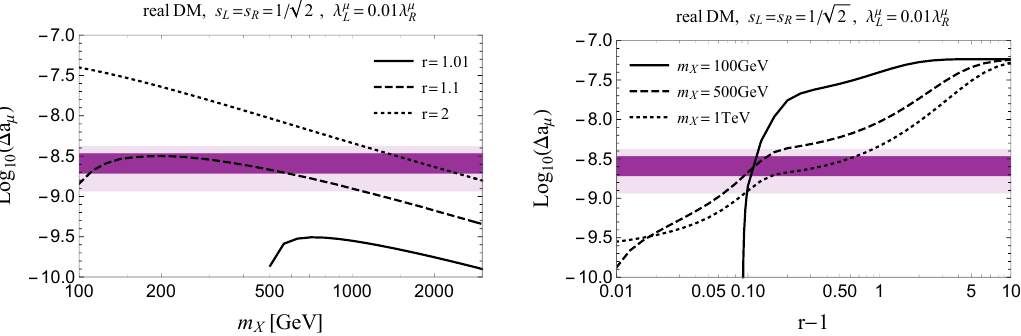
Figure 9 . (cid:1) a (cid:22) in the real scalar DM model as functions of the DM mass m X and degeneracy r 1, where r m E =m X . The solid, dashed and dotted lines are r = 1 : 01, 1 : 1 and 2 on the left 1 (cid:0) (cid:17) panel and m X = 100, 500 GeV and 1 TeV on the right panel. The Yukawa coupling (cid:21) L = 0 : 01 (cid:21) R is (cid:12)xed via the thermal relic abundance. (cid:1) a (cid:22) is explained within 1 (cid:27) (2 (cid:27) ) uncertainties on the (light) purple band. We assume the maximal mixing, s L = s R = 1 = p 2 and (cid:21) (cid:22)